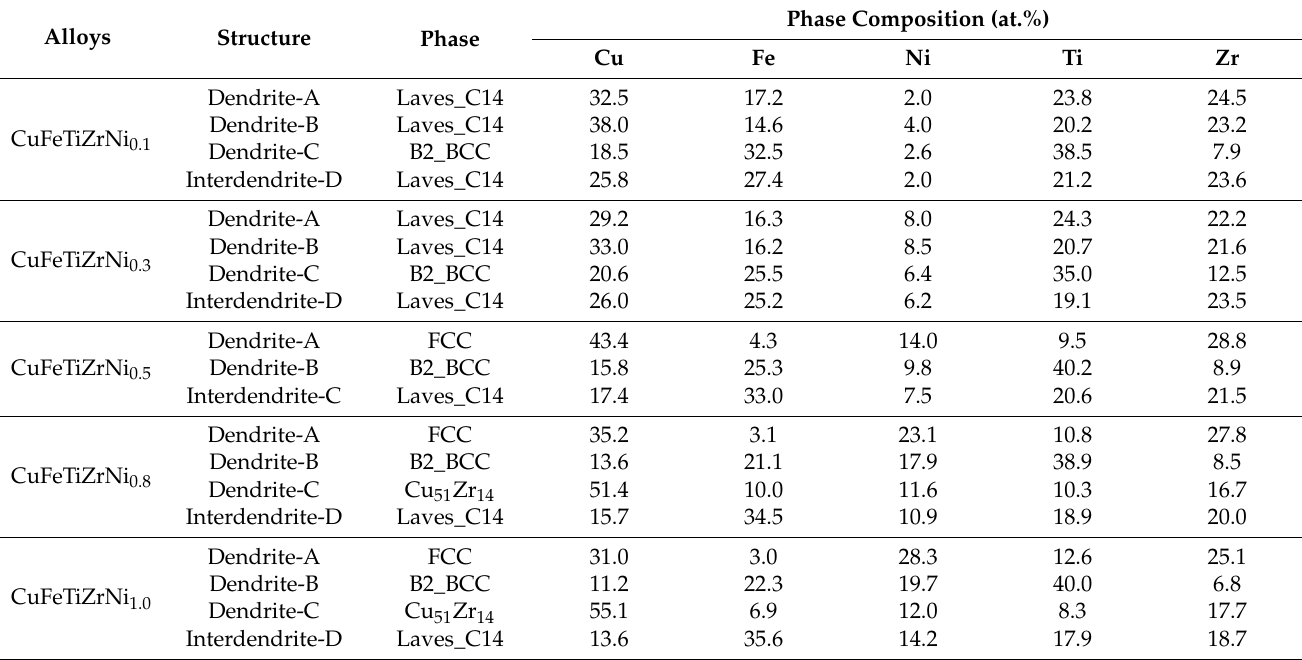
Table 1. The chemical composition of the CuFeTiZrNi x alloys in terms of atomic percentage ( x = 0.1, 0.3, 0.5, 0.8, and 1.0 in molar ratio).